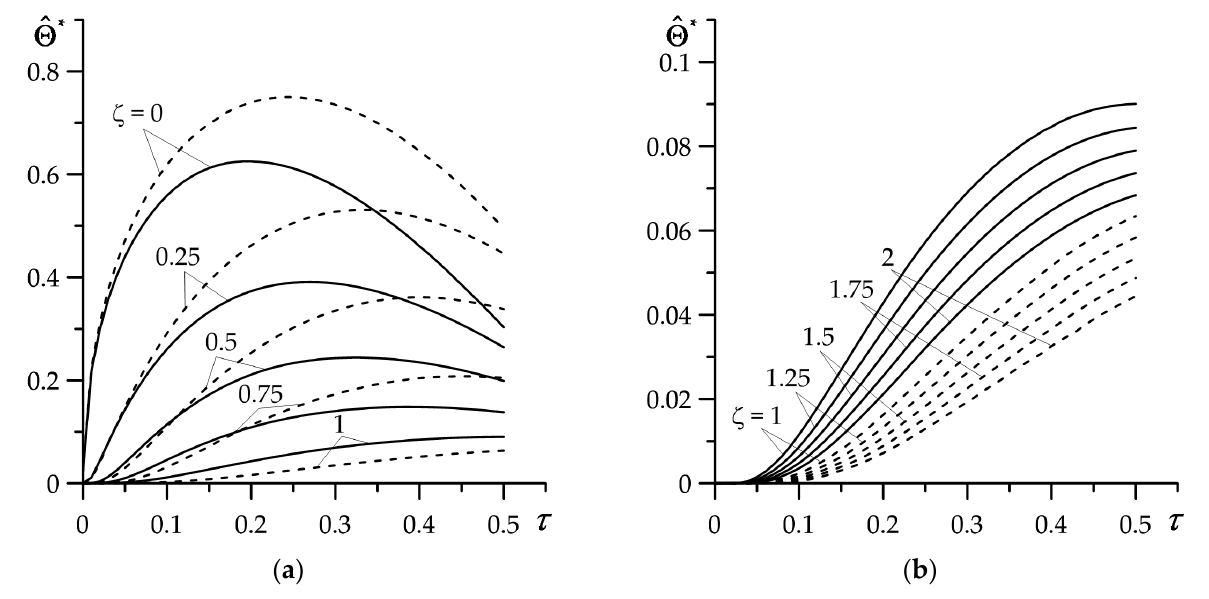
),(ˆ τζ ∗ Θ ∗ ( Figure 6. Evolution of dimensionless temperature rise ˆ Θ ζ , τ ) (113), (114) for selected dimensionless Figure 6. Evolution of dimensionless temperature rise (113), (114) for selected dimen- ζ values of spatial variable ζ in: ( a ) coating, ( b ) substrate. Solid lines—FGC, dashed lines—homogeneous in: ( a ) coating, ( b ) substrate. Solid lines—FGC, dashed sionless values of spatial variable coating made of ZrO 2 lines—homogeneous coating made of ZrO 2 .